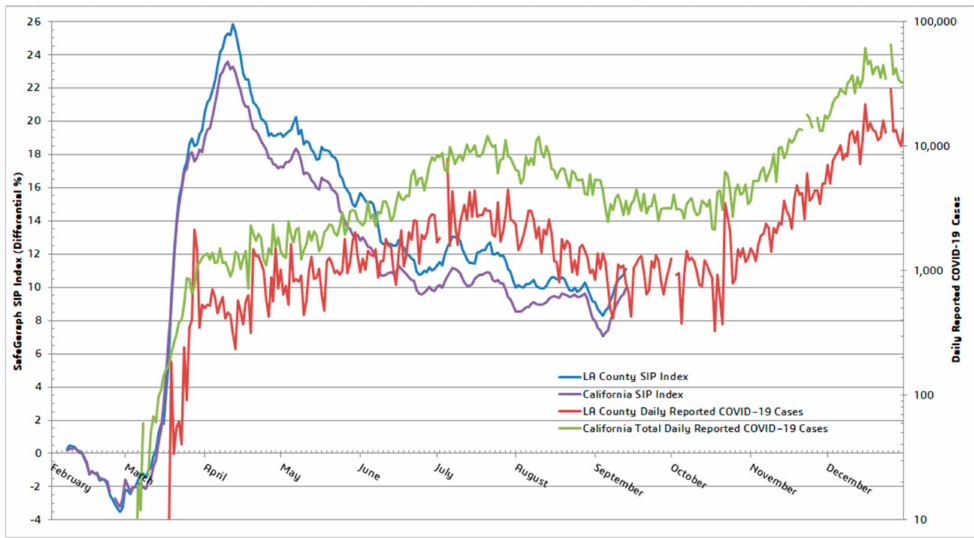
Figure 1. Comparison of LA County and all of California for shelter-in-place response and COVID-19 diagnosed cases over time. Data sources: California Department of Public Health [41], SafeGraph, Inc. [21]. The SIP Index represents the change (as a difference) in the % of people staying home compared to pre-pandemic baseline. The index ranges from − 100% to 100%, where 0 (zero) is no change from a pre-pandemic